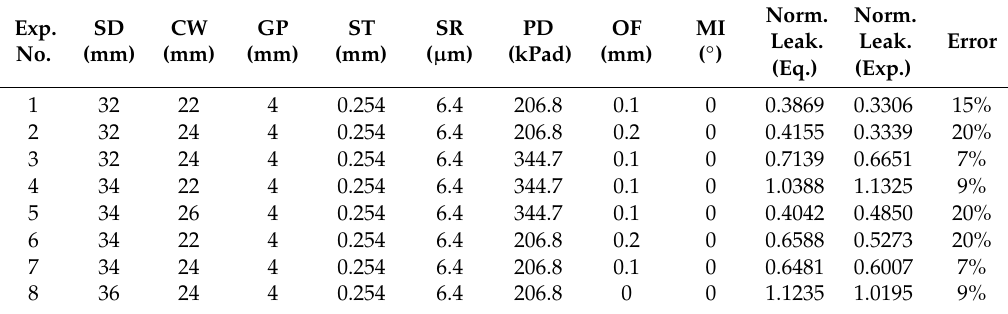
Table 8. Leakage rate error between additional confirmation experiments and closed form equation. Exp.